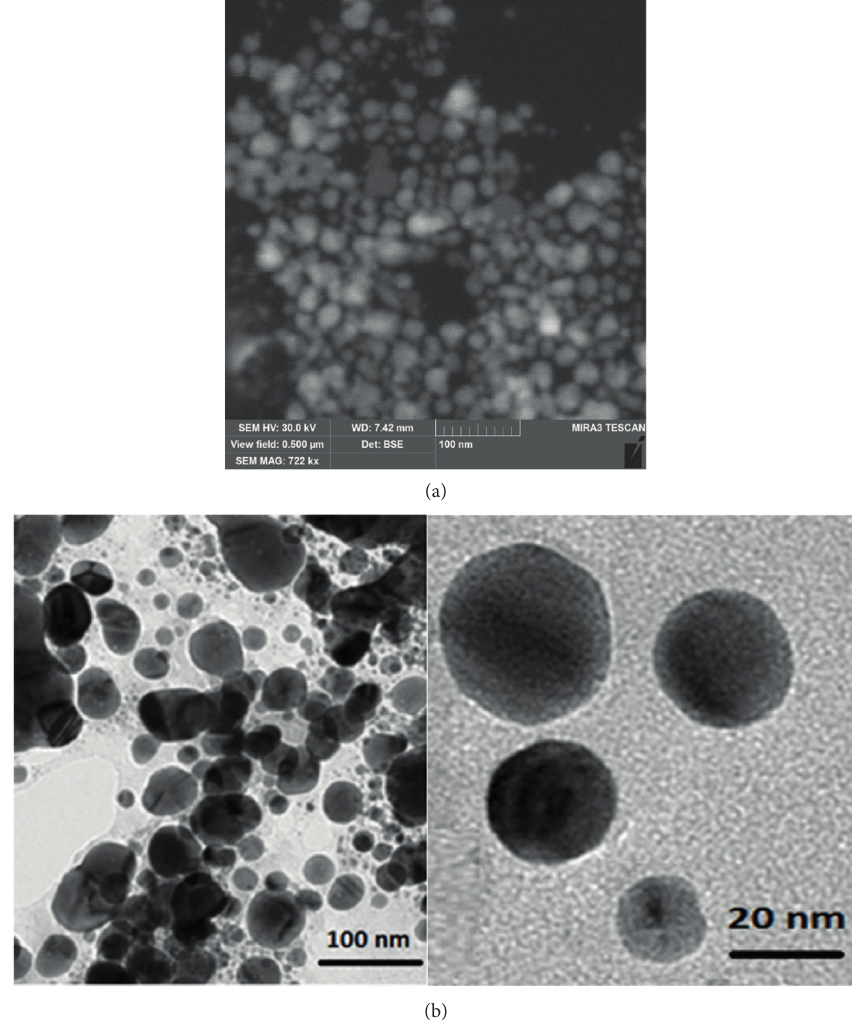
AgNO3 3.0mmol/l) (Skiba et al.